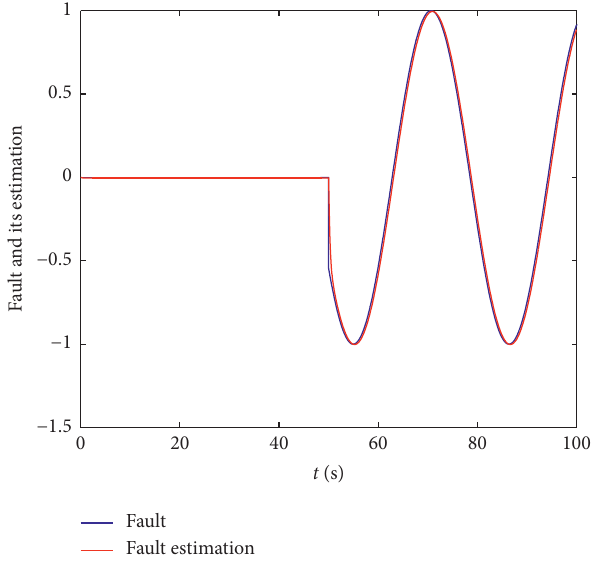
Figure 9: Fault and fault